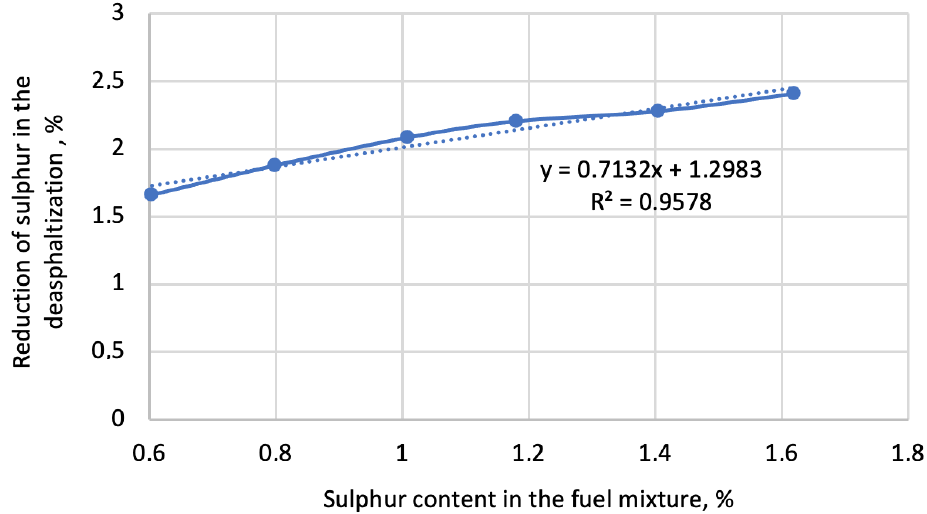
Figure 5. Reduction of sulphur in the deasphaltisation depending on the sulphur content in the fuel mixture.